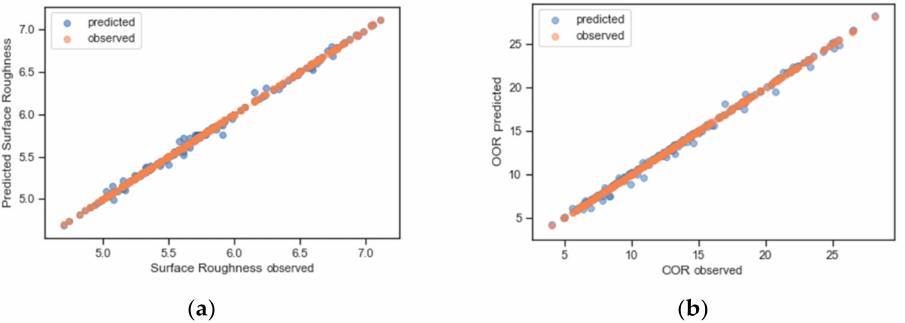
Figure 26. Predicted versus observed for ( a ) surface roughness and ( b ) change in